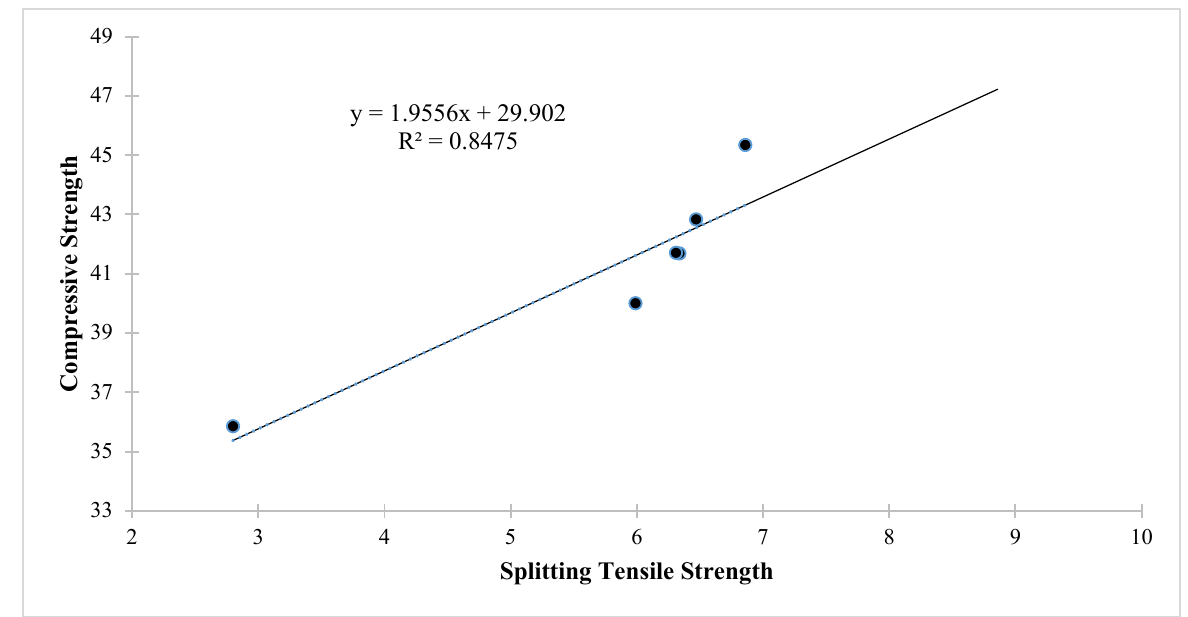
Figure 8. Relationship between concrete’s split tensile and compressive strengths.